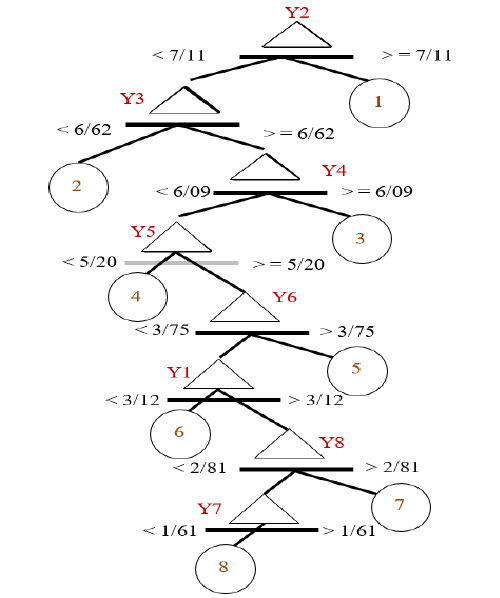
Figure 1. Feature selection using decision tree